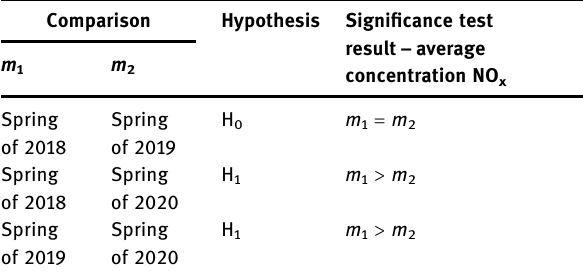
Table 2: Summary of signi fi cance test results Comparison